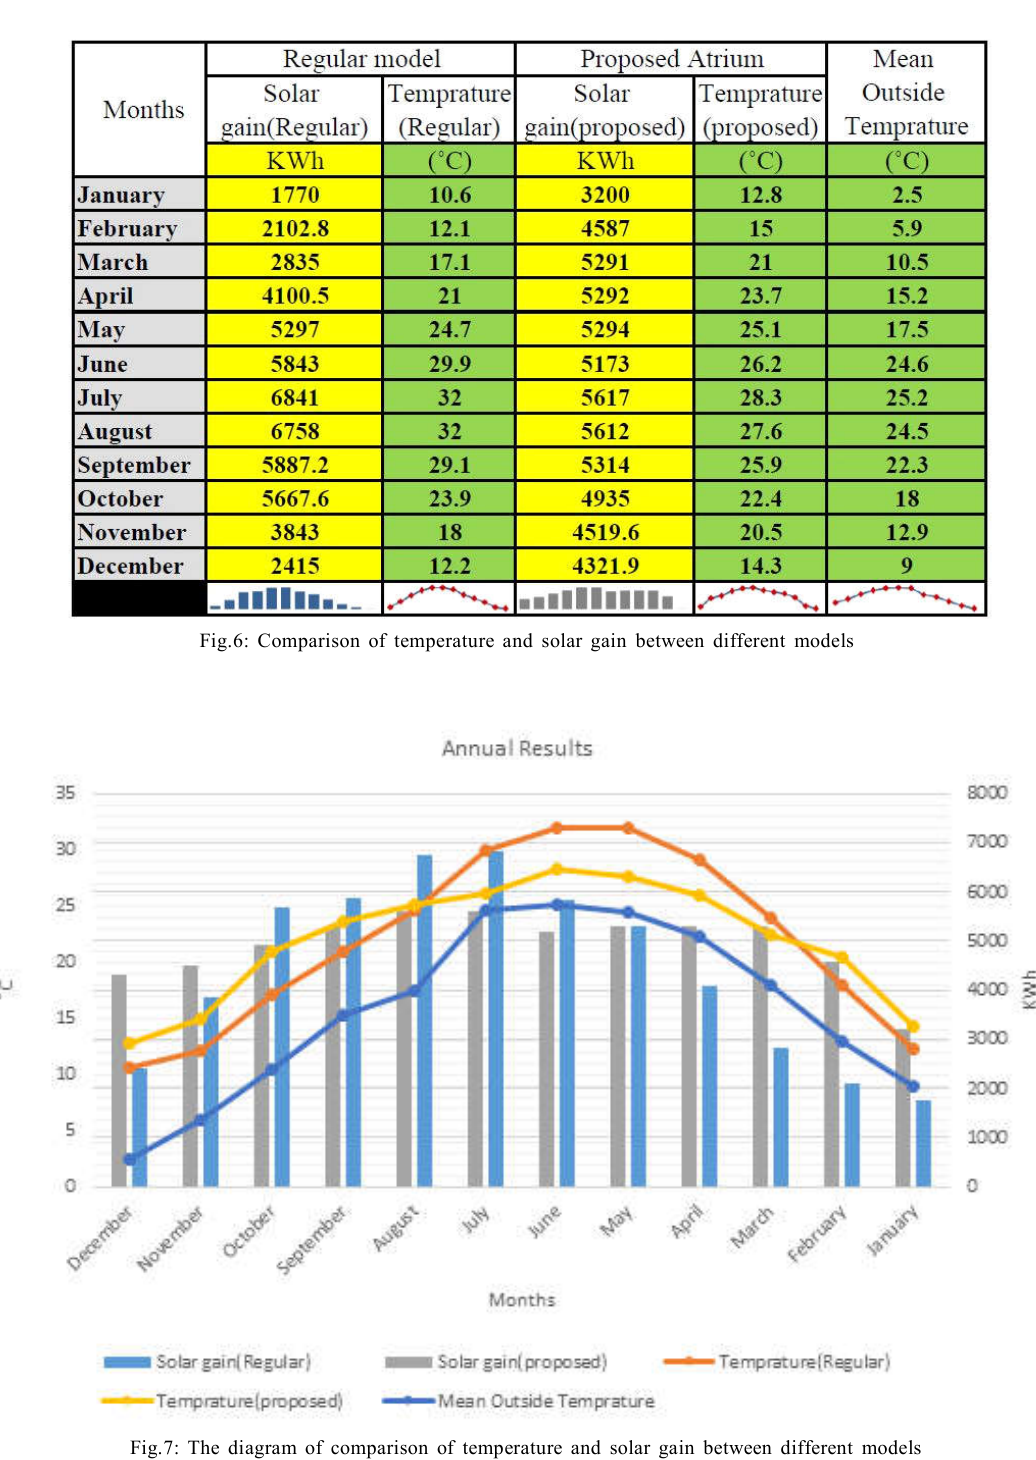
Fig.7: The diagram of comparison of temperature and solar gain between different models